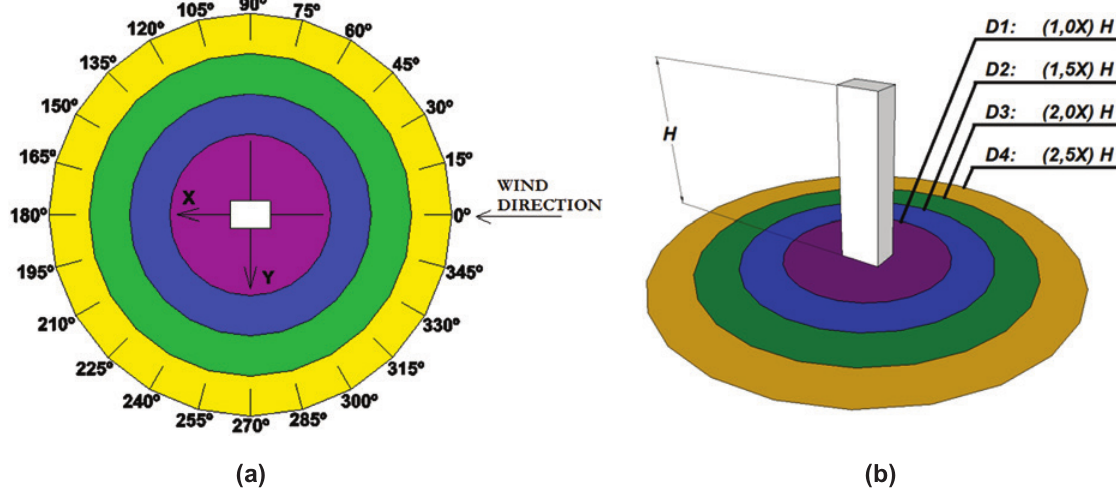
(a) Studied wind incidence direction; (b) Distances for the neighboring buildings’ positioning